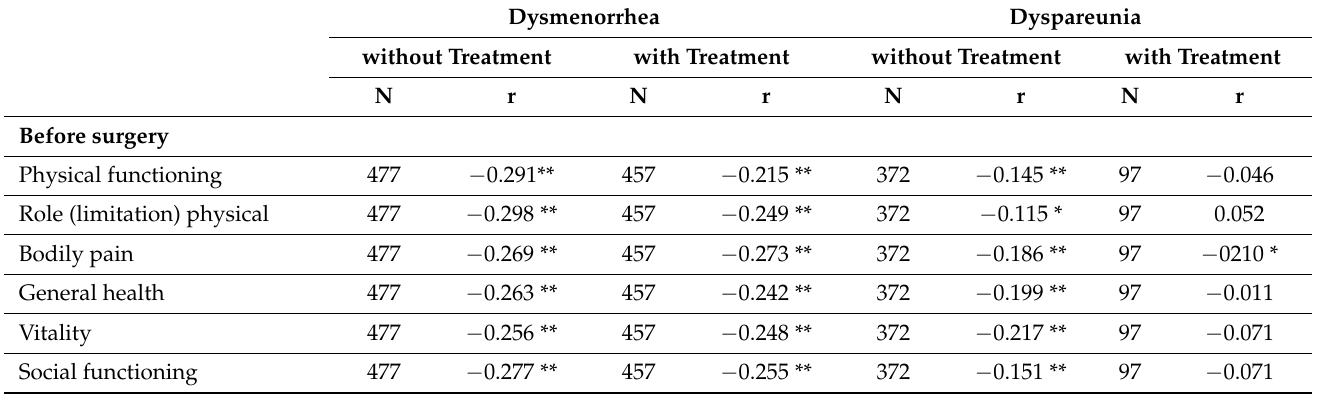
Table 6. Pearson correlations between SF-36 subscale and component scores and dysmenorrhea/dyspareunia VAS, before and one year after